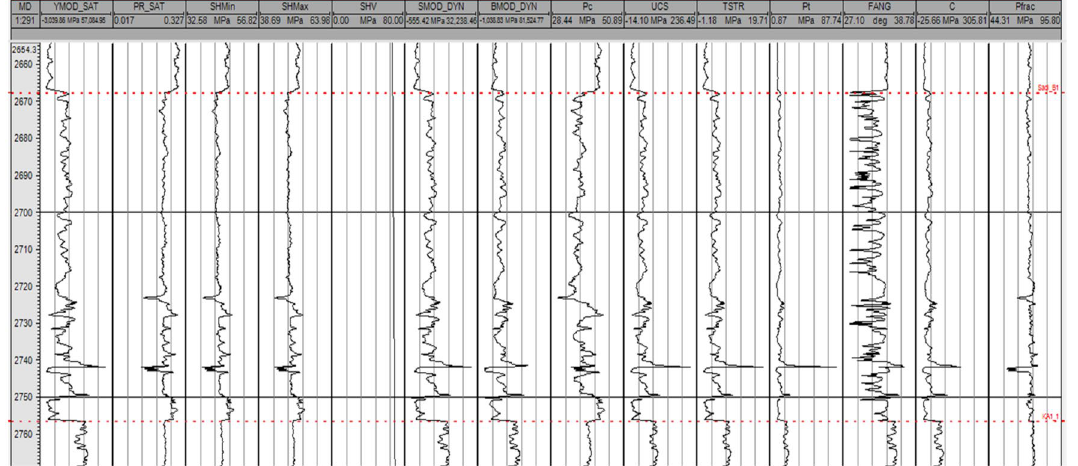
Fig. 11 One-dimensional rock mechanics parameters of well N52